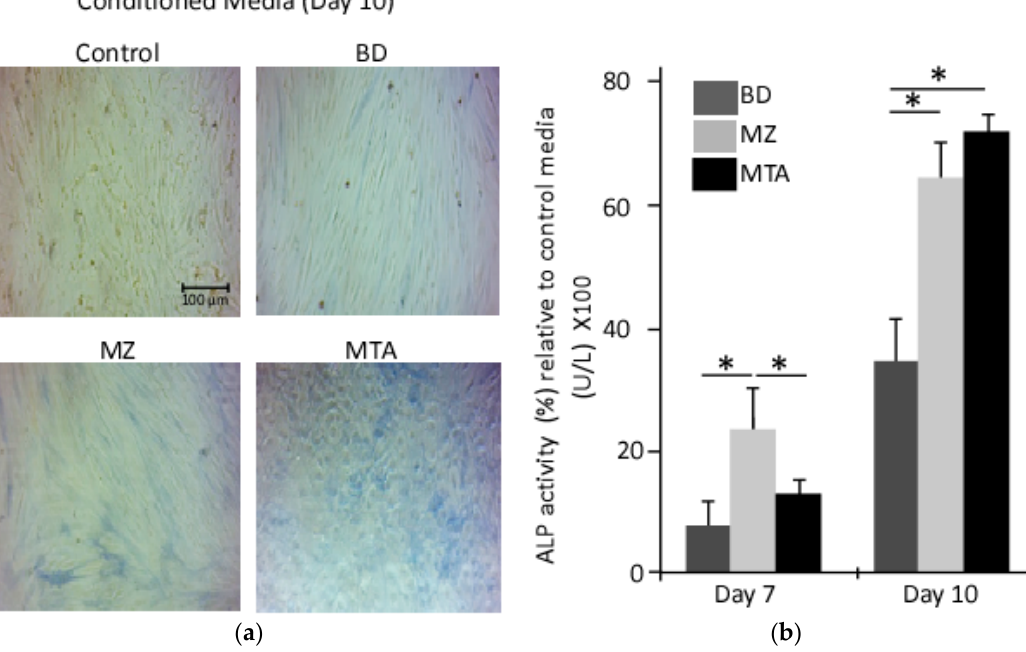
Figure 3. Alkaline phosphatase activity assay. A time course detection for ALP activity in differentiated DPPSCs seeded on conditioned media, days 7 and 10. ( a ) ALP was detected with the chromogenic substrate from the ALP staining kit; ( b ) ALP activity was measured in differentiated DPPSCs seeded on the biomaterials conditional media, days 7 and 10 (*: p < 0.01).